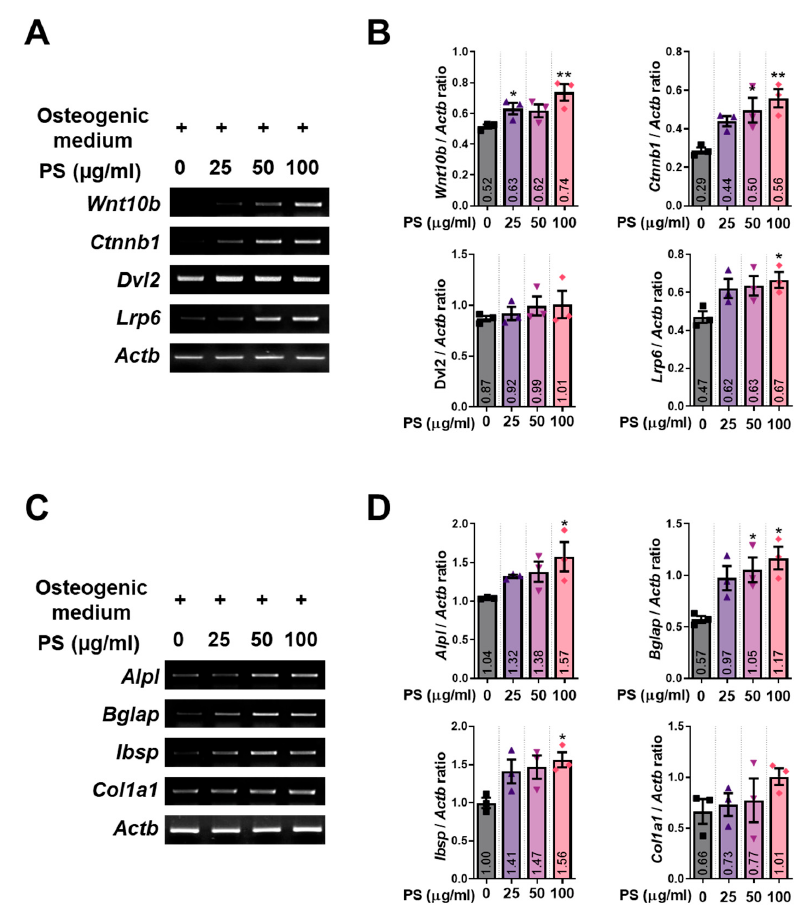
Figure 3. Wnt/ β -catenin signaling indicators were elevated at the mRNA level in response to PS treatment. ( A ) The effect of PS on the Wnt/ β -catenin mechanism verified by RT-PCR. ( B ) The expression of each gene was quantified through normalization with Actb . Osteoblast activation factors were elevated at the gene level due to PS treatment. ( C ) The effect of PS on the expression of osteogenesis-related genes was verified through RT-PCR. ( D ) Expression of each gene was quantified through normalization with Actb . All experiments were repeated at least three times. The shapes (triangles, squares, etc) shown in each graph are values for each round of the experiment. Data are expressed as mean ± SEM. ** p < 0.01, * p < 0.05 versus the cells treated only with osteogenic